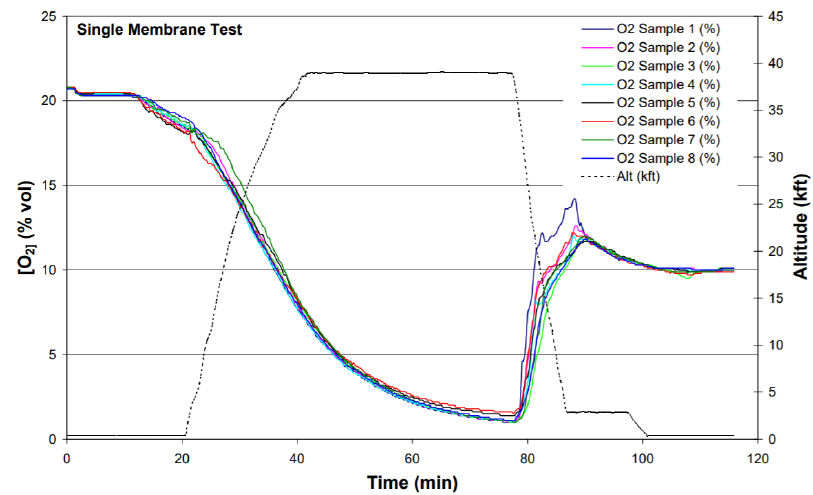
Figure 6. Inerting flight test tank oxygen concentration measurements for an empty tank in different positions (samples). Note that the increase in oxygen concentration at t = 78 min is due to air ingestion in the fuel tanks during the descent phase (source